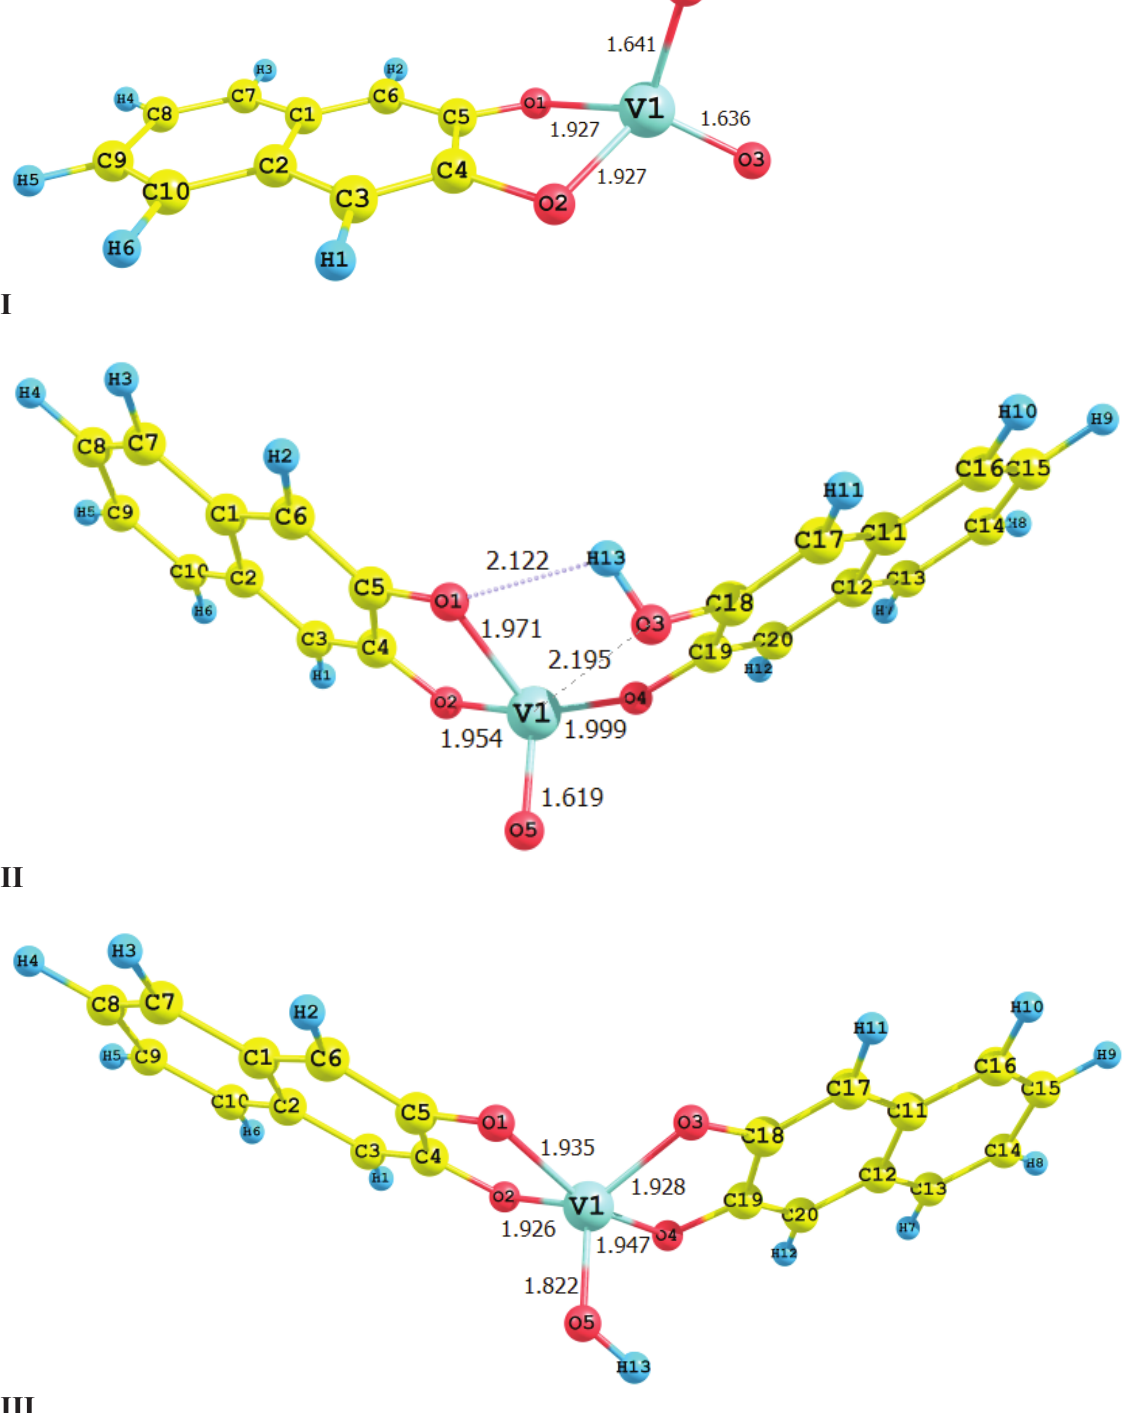
Figure 7: The optimized ground-state geometry of monoanionic chelates of V V (structure I ) and V IV (structures II and III ) with